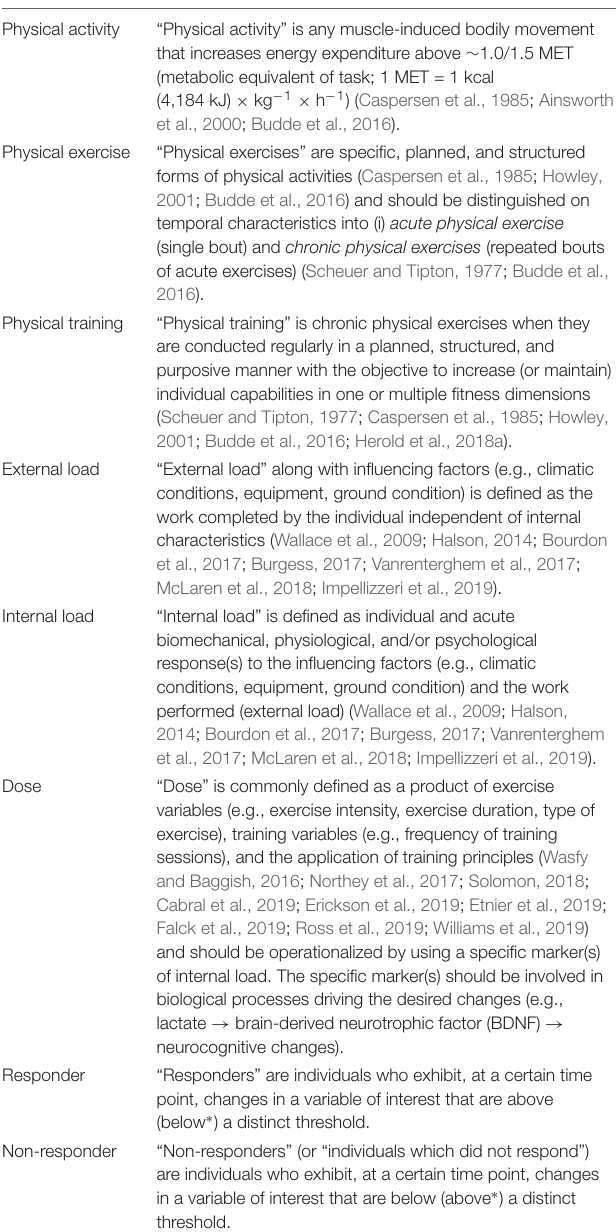
TABLE 1 | Overview about the definitions of terms relevant to interindividual heterogeneity and exercise–cognition research ∗ Please note that “above” and “below” are relative to the favorable outcome in the variable of